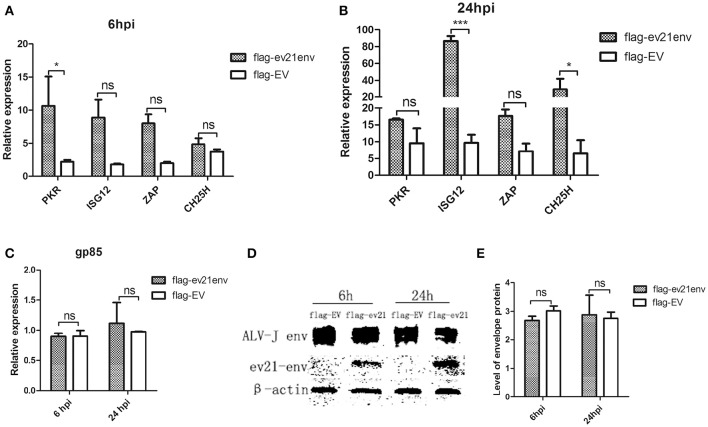
Analysis of M180 strain replication and ISGs expression. DF-1 cells transfected with flag-ev21env or flag-EV and infected with M180 strain at 24 h post-transfection. (A) Quantitative analysis of the expression of PKR, ISG12, ZAP and CH25H at 6h post infection. (B) Quantitative analysis of the expression of PKR, ISG12, ZAP and CH25H at 24 h post infection. (C) M180 strain production was measured by qPCR at 6 and 24 hpi. (D) M180 strain production was measured by Western blot at 6 and 24 hpi. (E) The level of M180 strain envelop protein was measured by Image J 1.48. *p < 0.05, ***p < 0.001. ns, not significant.